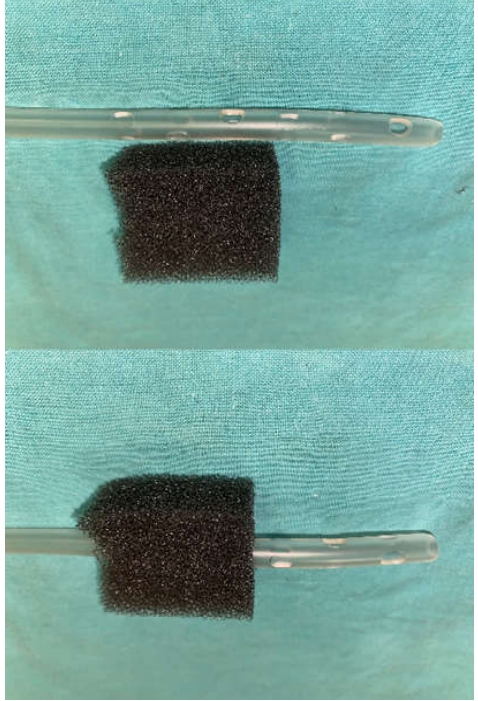
Figure 1. A view of the case after the first NPWT dressing.